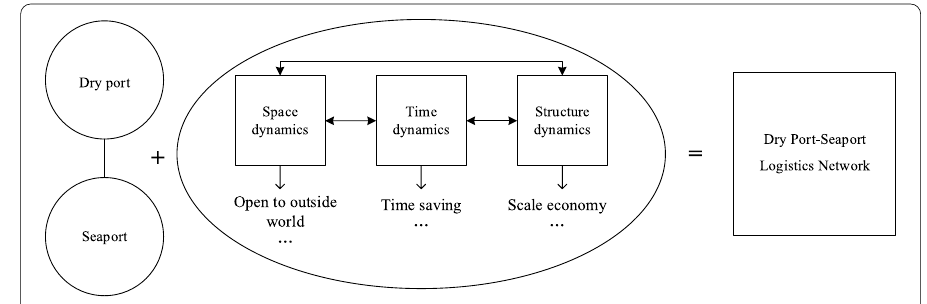
Fig. 4 Evolution process of dry ports in and outside Shandong